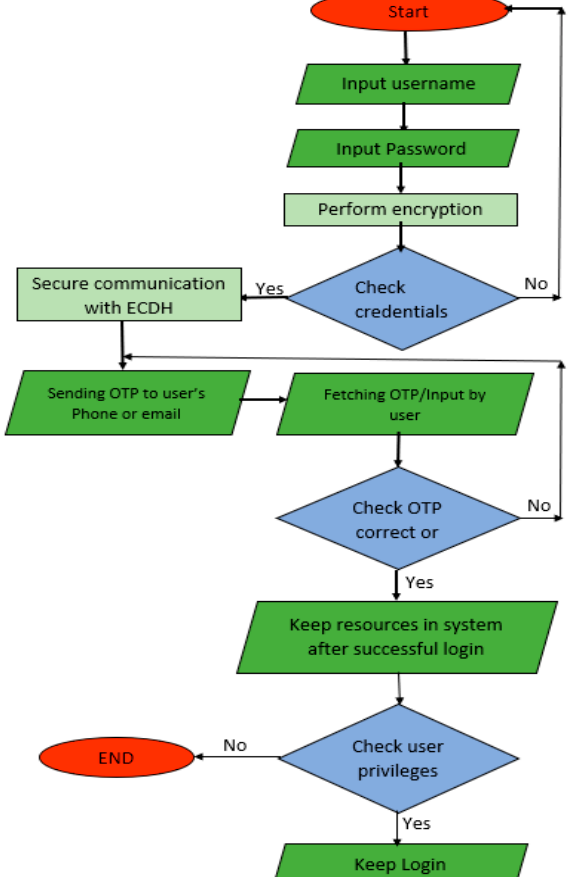
Figure 8. Flow of authentication system.